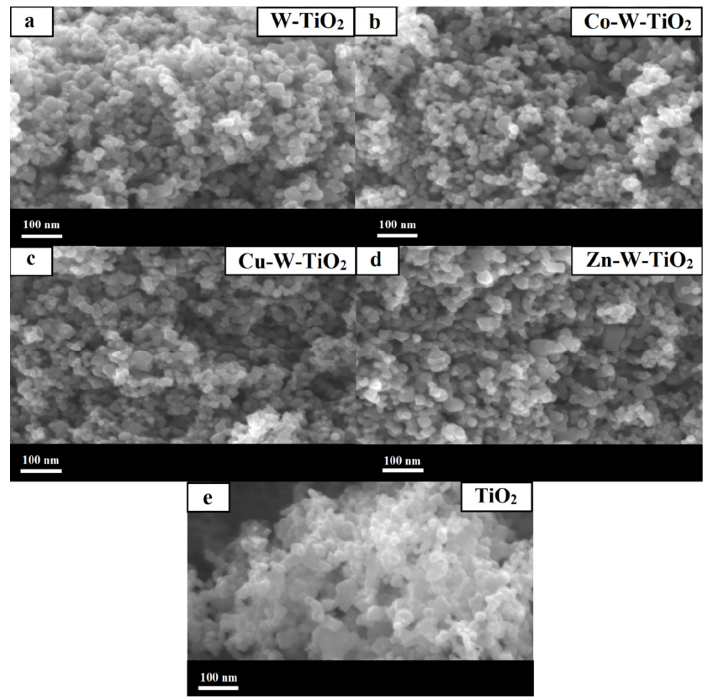
Figure 7. SEM images of ( a ) W ‐ TiO 2 , ( b ) Co ‐ W ‐ TiO 2 , ( c ) Cu ‐ W ‐ TiO 2 , ( d ) Zn ‐ W ‐ TiO 2 , and ( e ) TiO 2 . Nanomaterials 2022 , 12 , x FOR PEER REVIEW Notably, close ‐ up TEM images (Figures 8 and 9) reveal lattice spacing values of 0.37– 0.41 nm that correspond to the [101] plane of TiO 2 anatase. Overall, the results obtained from SEM and TEM characterizations (average particle size, crystal structure) are in good agreement with XRD and Raman findings.